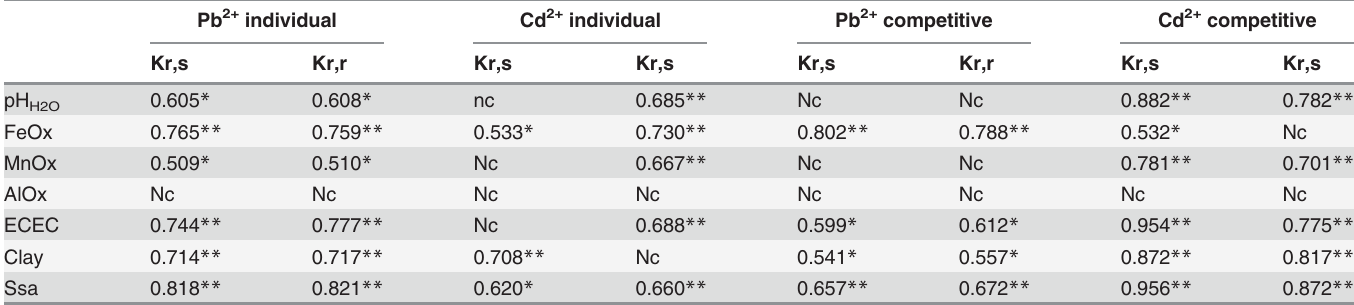
Table 3. Correlations between soil characteristics and the Kr for individual and competitive sorption or retention of Pb 2+ and Cd 2+ . Pb 2+ individual Cd 2+